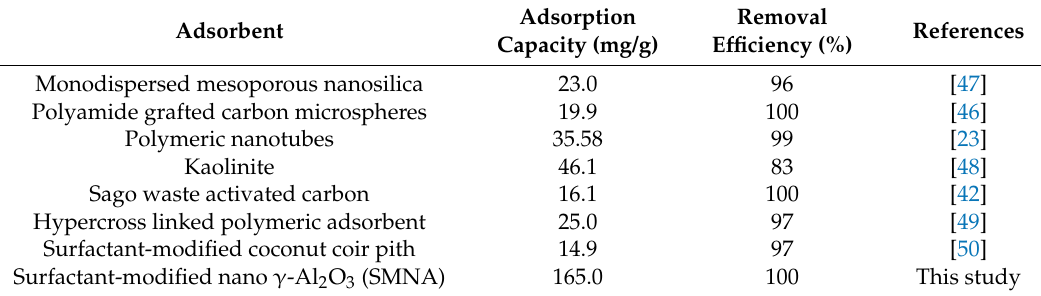
Table 2. Adsorption capacity and removal efficiency of surfactant-modified nano γ -Al 2 O 3 (SMNA) and other absorbents for removal of Rhodamine B (RhB).